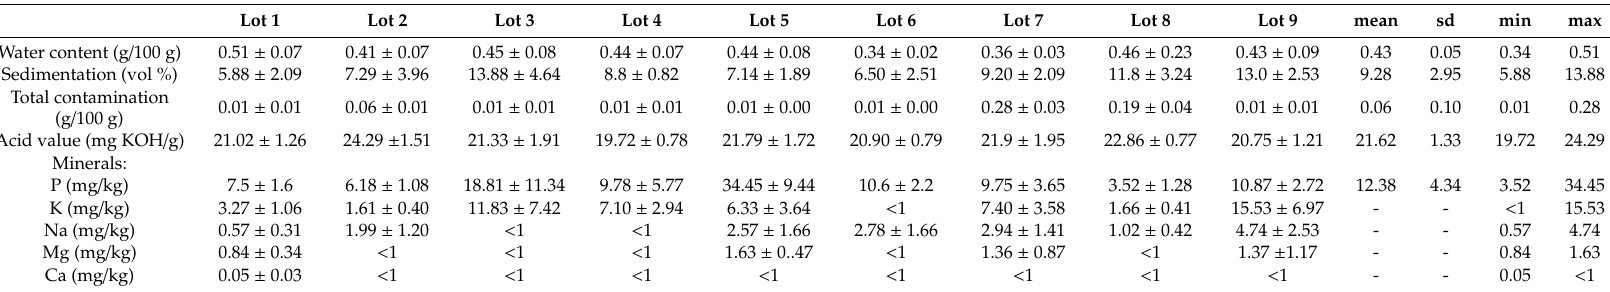
Table 1. Chemical characteristics of corn oil from a dry-grind corn ethanol plant. Data obtained by ENVIRAL on samples collected over a one-year period